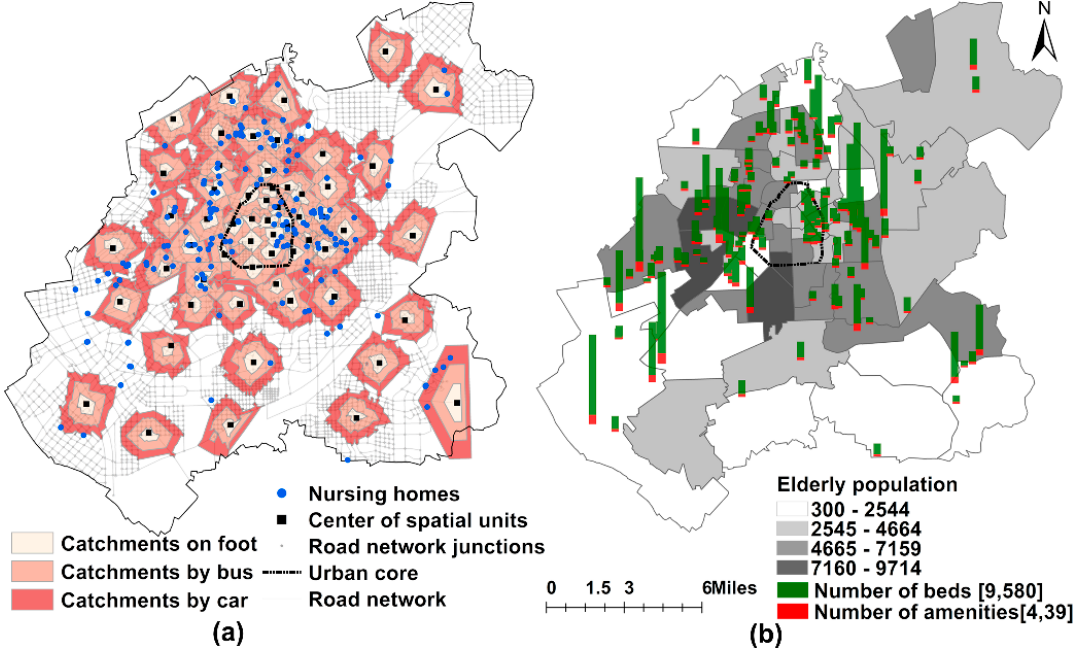
Figure 2. The network analysis data set of nursing homes in Changchun. ( a ) the road network and locations of nursing homes; ( b ) the spatial distribution of elderly population and the capacity of nursing homes.